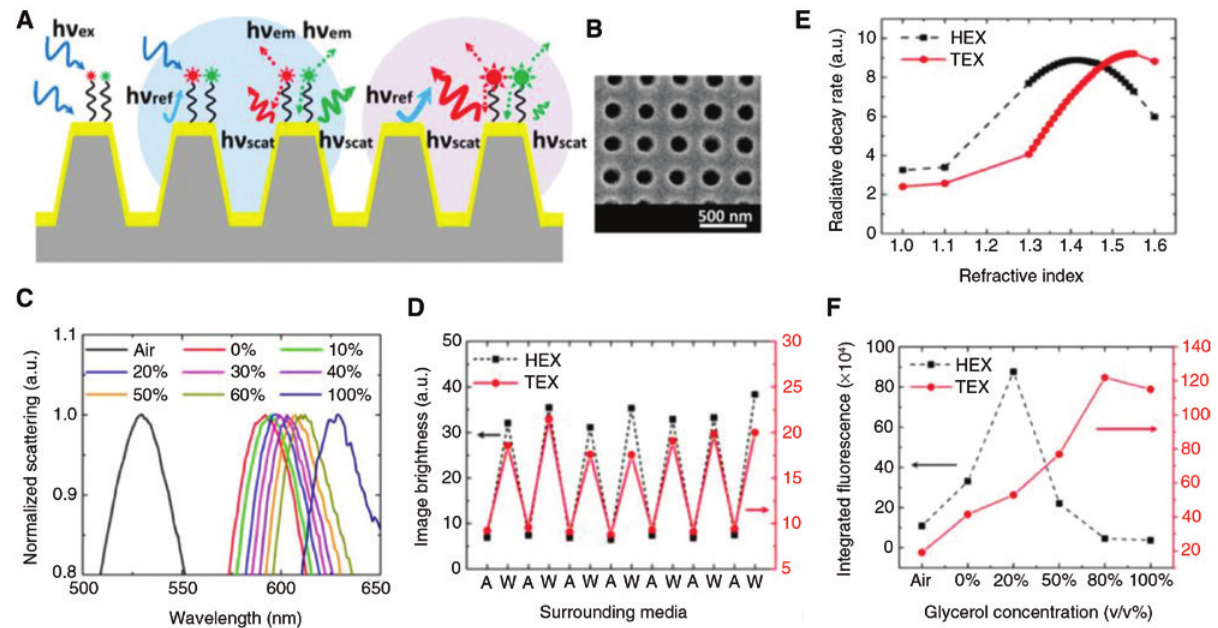
Figure 4: Fluorescence enhancement on nanocup array structure (nanoLCA). (A) A schematic representation of the fluorescence enhancement on the nanocup array structure is presented. The nanocup array polymer substrate is in gray, gold layer deposited on the substrate is in yellow, and two different refractive indexed media are in blue and purple color. Green and red point sources are HEX and TEX dye, respectively. In different media, reflected light intensity ( h ν ) and scattered light ref intensity ( h ν ) differ despite the same excitation light intensity ( h ν ), resulting in different fluorescence emission intensities ( h ν ). scat ex em (B) The SEM image of nanocup arrays. (C) The scattering peak position shifts to red with increasing concentration of glycerol. (D) Dynamic fluorescence image brightness response with alternate flows of air (A) and water (W). (E) The radiative decay rate on the surface of the nanocup structure with different surrounding refractive indices. (F) Integrated fluorescence emission curves of HEX and TEX show their maxima at different refractive indices. HEX has maximum integrated fluorescence intensity with 20% glycerol, but TEX has it with 80% glycerol (A–F adapted from Ref. [62] with permission from The Royal Society of